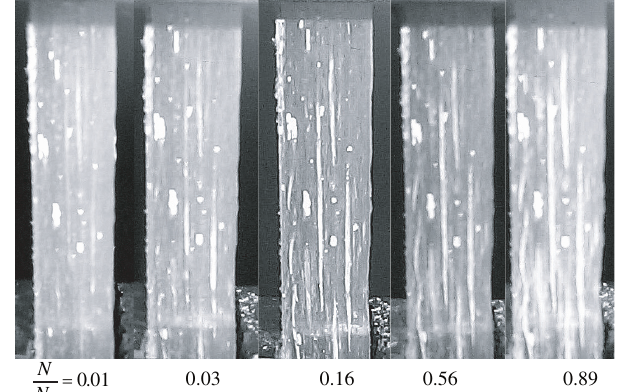
Figure 7. Damage sequence for laminate C12 tested with R = 10 (N = 38700 cycles, σ 0